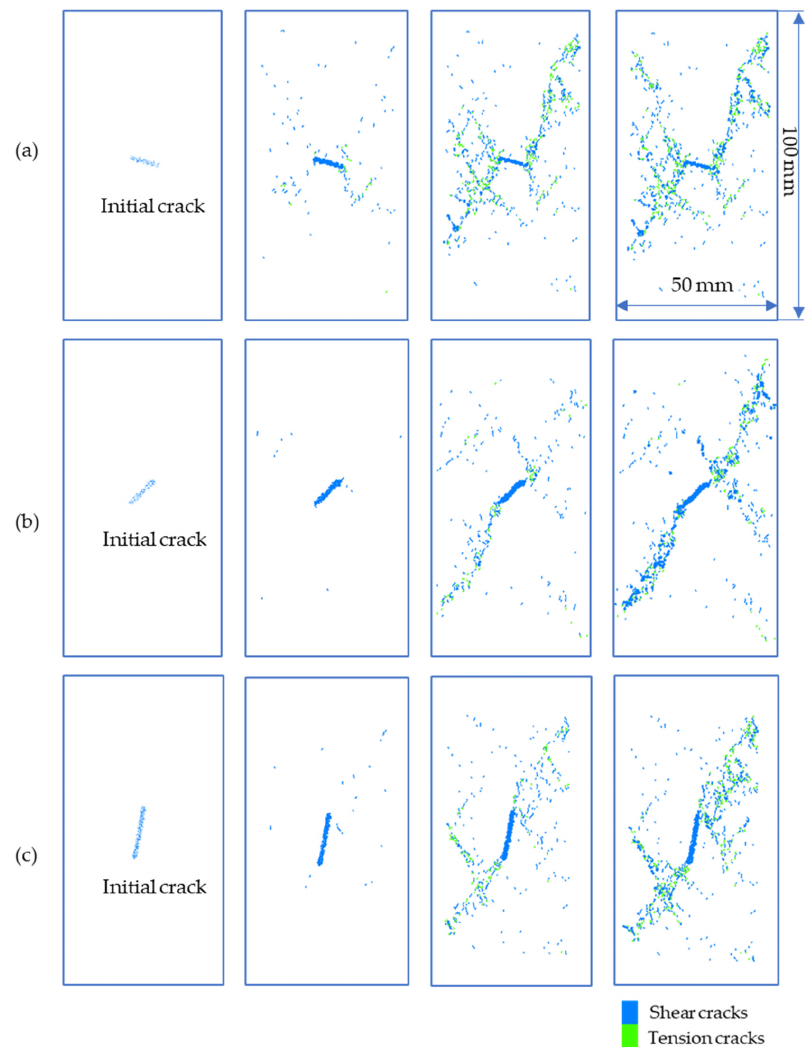
Figure 10. The wing crack propagation of different pre-cracked samples. ( a ) 15°; ( b ) 45°; ( c )